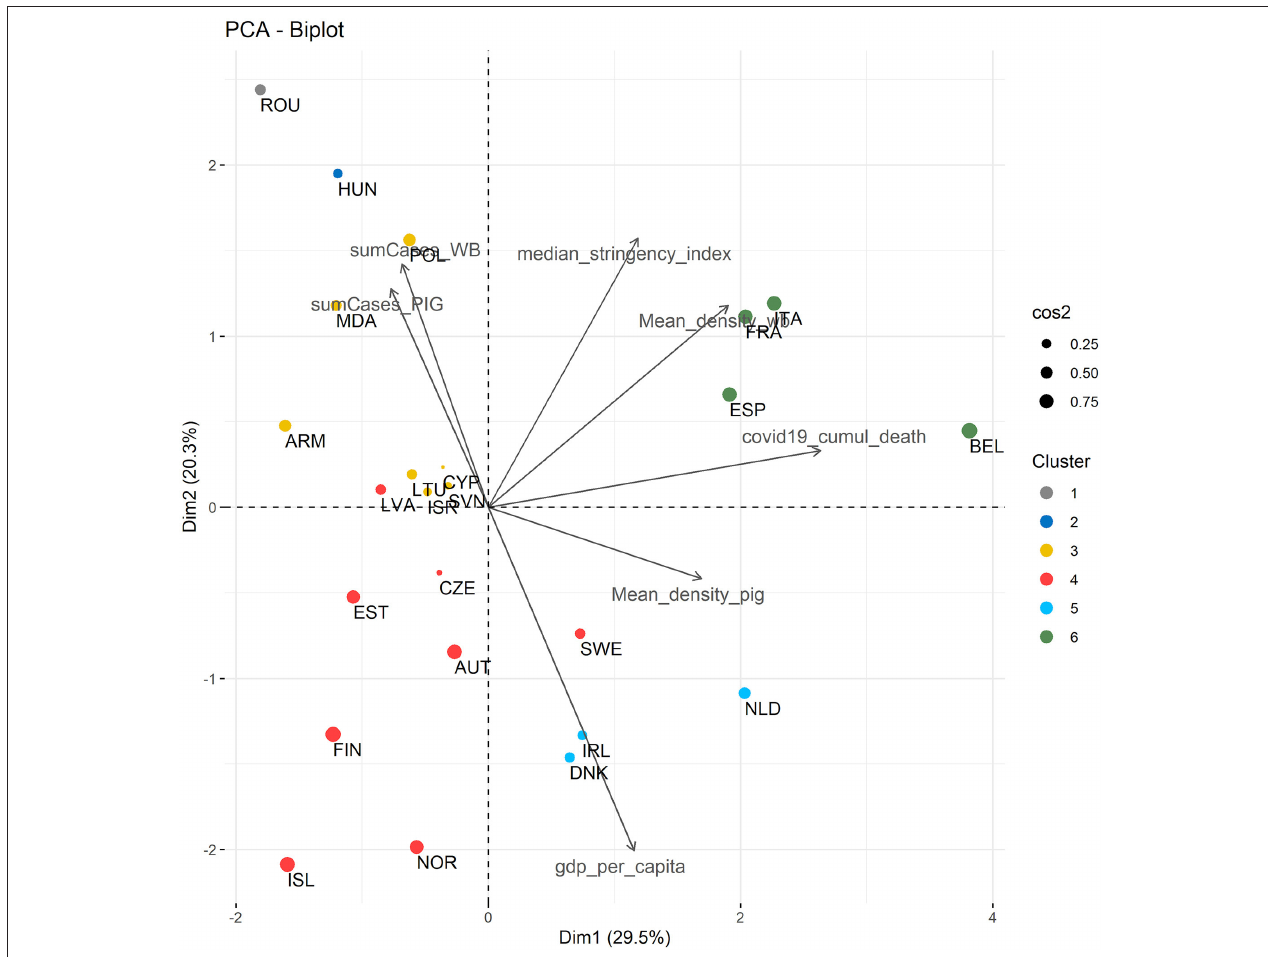
FIGURE 2 | Biplot of the first two axes of the principal component analysis (PCA) showing the clustering of the 24 participating countries based on sanitary and economic variables. Countries are colored according to their cluster. Dot size corresponds to cos2 value. ARM, Armenia; AUT, Austria; BEL, Belgium; CYP, Cyprus; CZE, Czech Republic; DNK, Denmark; ESP, Spain; EST, Estonia; FIN, Finland; FRA, France; ISL, Iceland; ISR, Israel; ITA, Italy; HUN, Hungary; IRL, Ireland; LVA, Latvia; LTU, Lithuania; MDA, Moldova; NLD, Netherlands; NOR, Norway; POL, Poland; ROU, Romania; SVN, Slovenia; SWE,